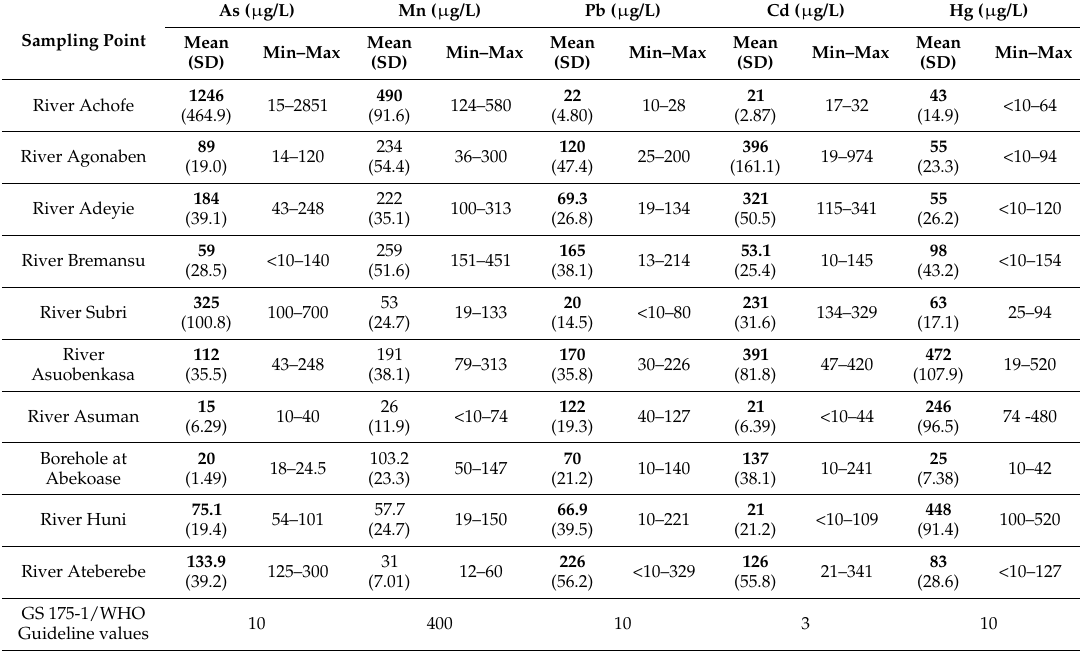
Table 2. Mean concentrations ( µ g/L) of heavy metals in filtered water samples from the study area. Data includes the minimum and maximum values from each sampling site. GSA-175A/WHO guideline for drinking water is shown for